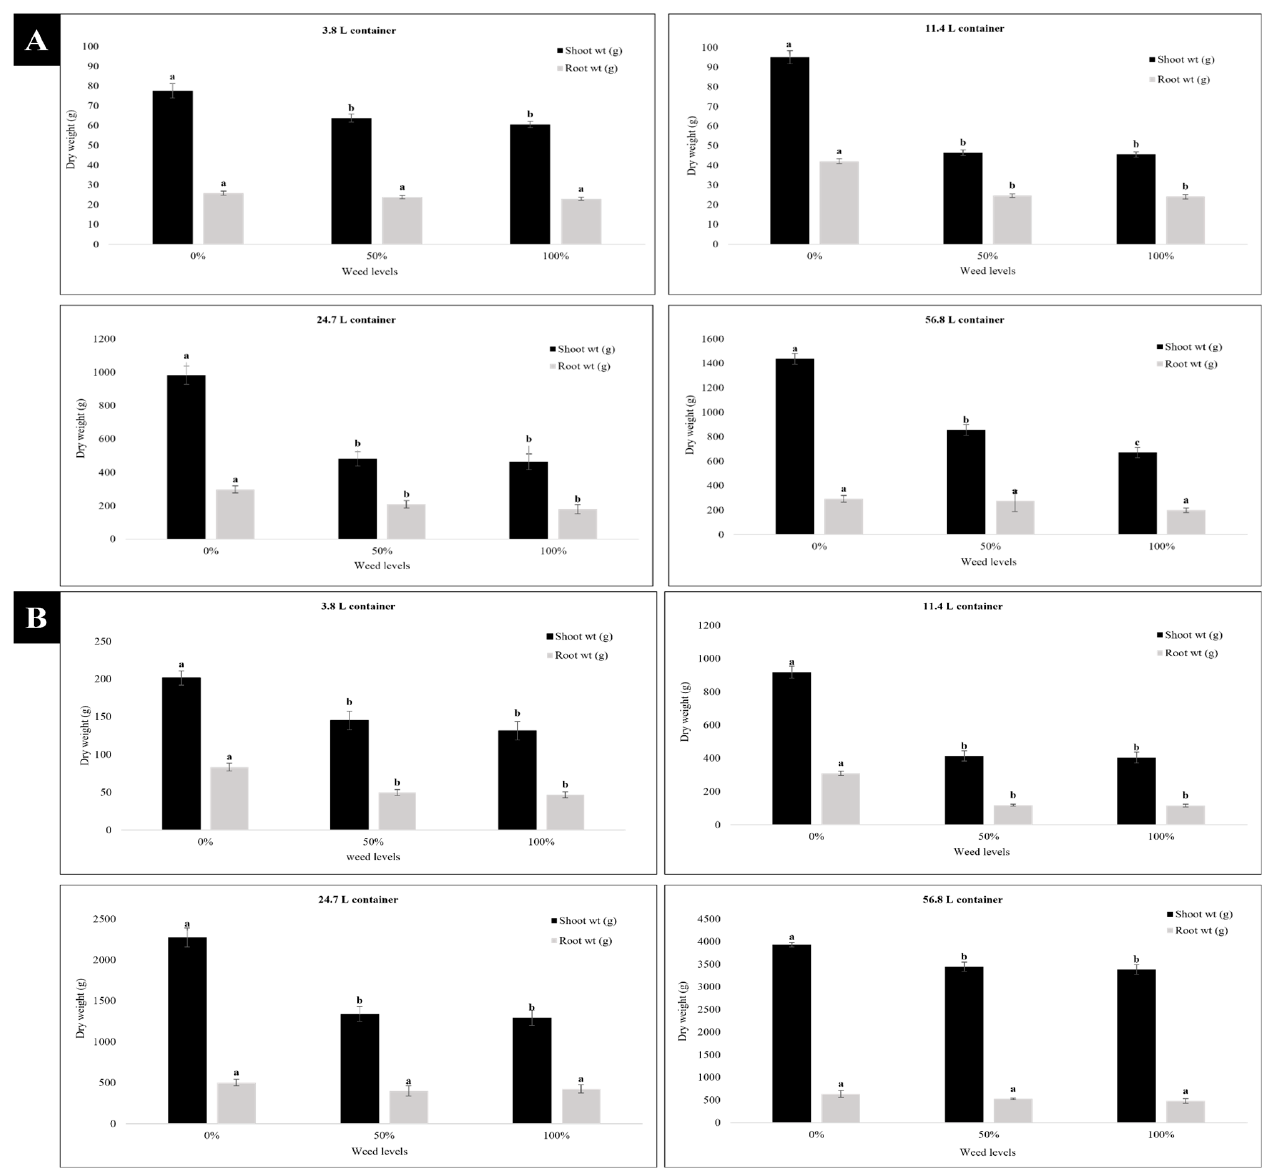
Figure 3. Figure ( A ) represents the shoot and root dry weight of Japanese holly, and figure ( B ) represents the shoot and root dry weight of ligustrum in 3.8 L, 11.4 L, 24.7 L, and 56.8 L containers at weed coverage levels of 0%, 50%, and 100% measured at the trial conclusion of 48 weeks after planting (WAP) to 60 WAP. Means followed by the same letter are not significantly different according to Tukey’s HSD test at p < 0.05. Error bars represent standard errors. 1 g = 0.0353 oz.